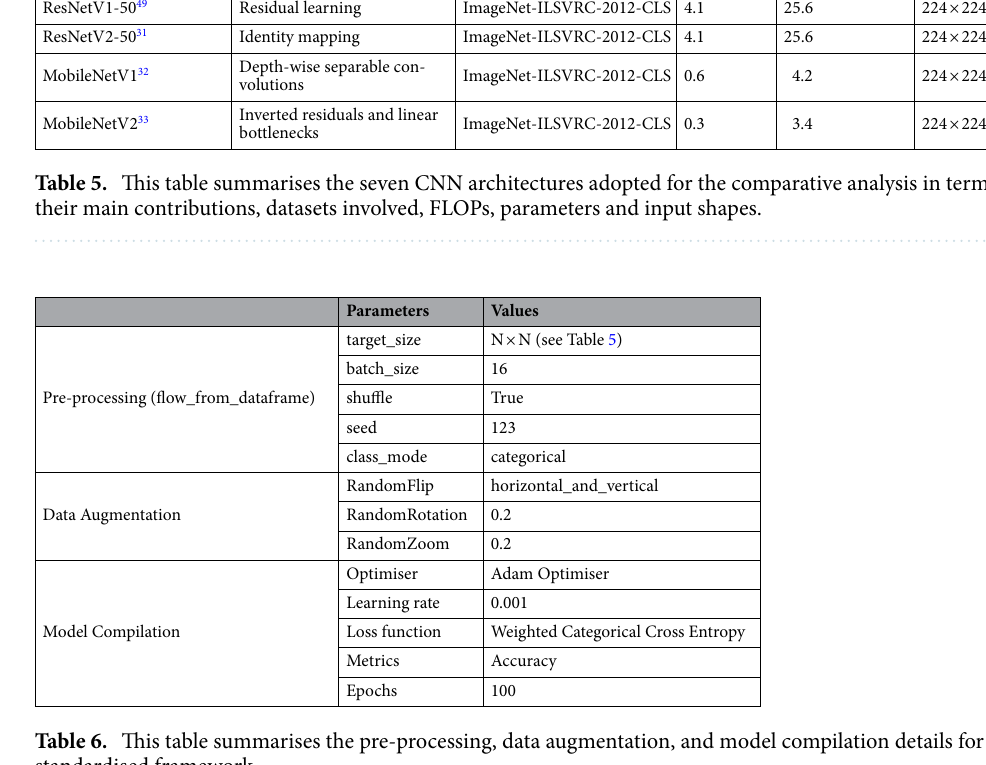
Table 6. This table summarises the pre-processing, data augmentation, and model compilation details for the standardised framework.